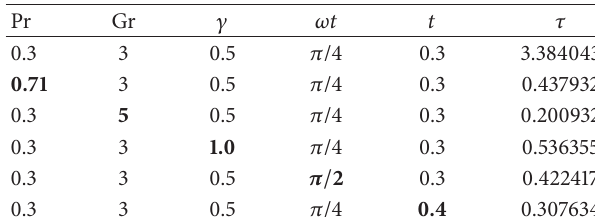
Figure 9: Profiles of temperature for different values of 𝑡 , when Pr = 0.71 . Table 1: Skin friction variations.